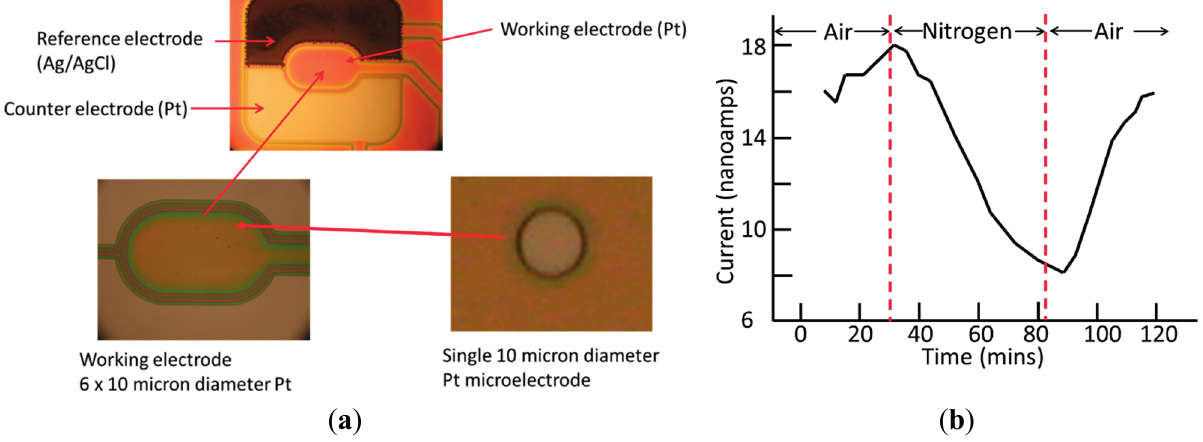
Figure 4. O 2 sensor: ( a ) Photograph of microfabricated oxygen sensor showing bare platinum working and counter electrodes; working electrodes = 6 off 10 micron diameter. ( b ) Amperometric response of (collagen-coated) oxygen sensor to nitrogen purging; and